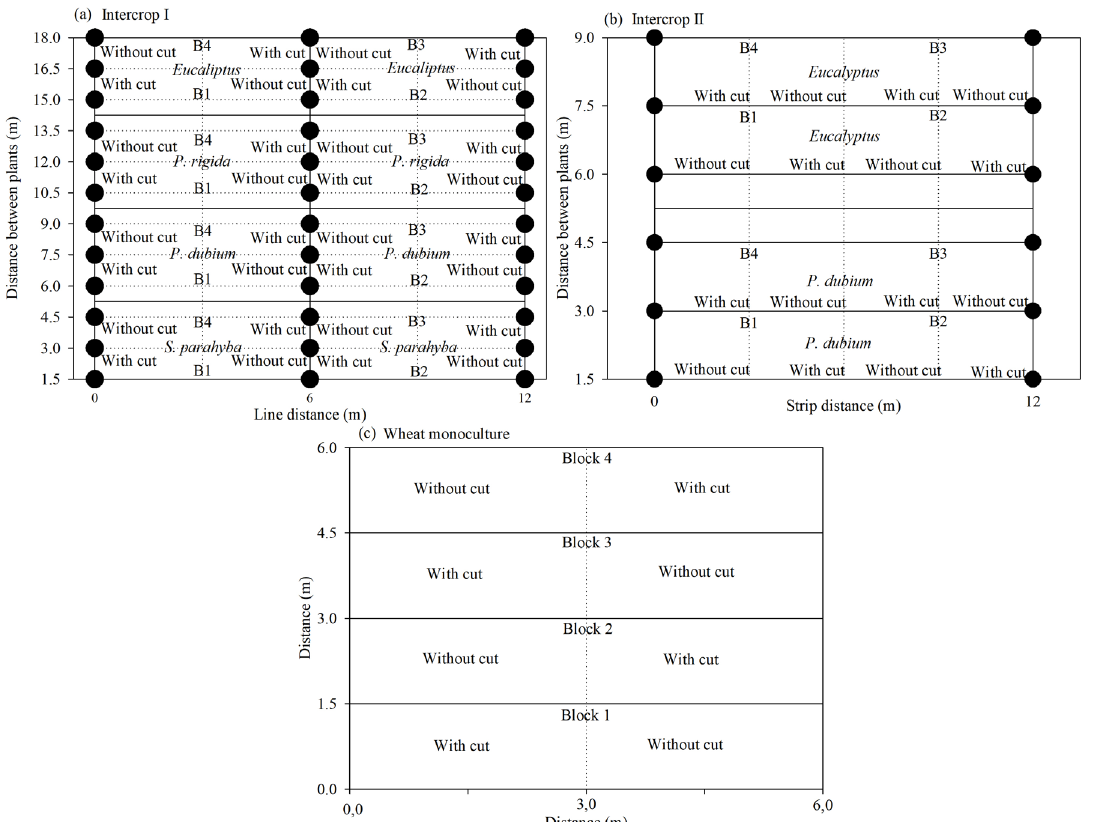
Figure 1 - Description of the sampling scheme for the agroforestry systems of two different spacings: (a) Intercrop-I (6 m between forages x 1.5 m between plants) and (b) Intercrop-II (12 m between forages x 1.5 m between plants); (c) dual- purpose wheat in monoculture. All systems with four blocks, and with or without grazing simulation (cut) dual-purpose wheat. Circles represent trees spaced 6 or 12 meters